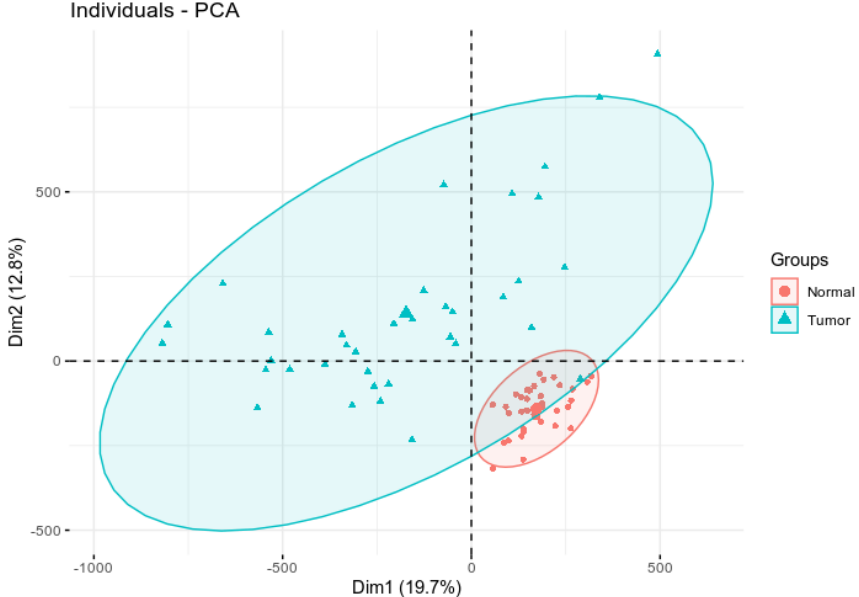
Figure 1. Principal component analysis plot showing differential clustering of tumor vs. control samples. The x axis represents the most variation in the data and the y axis represents the second most variation in the data.